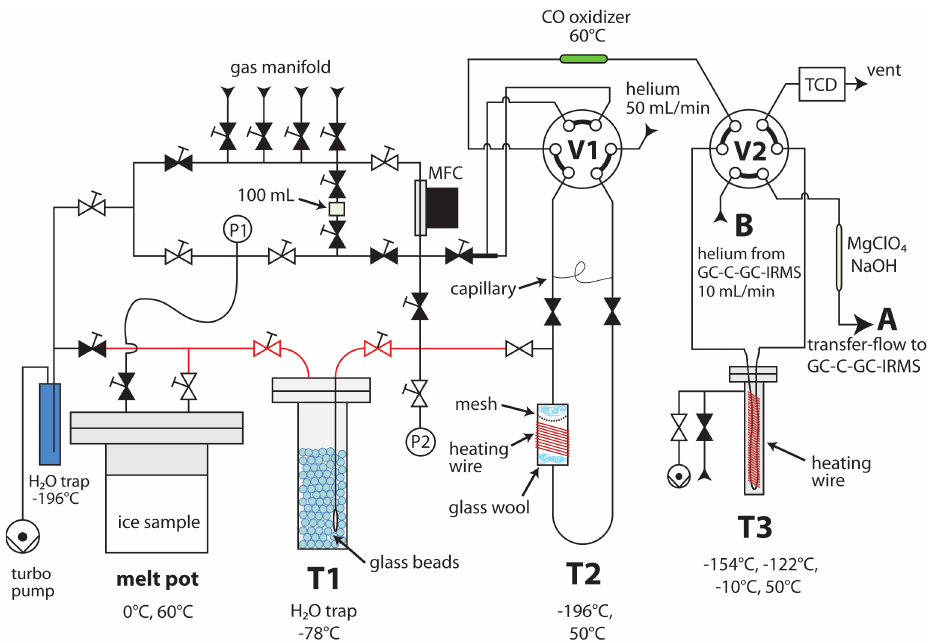
Fig. 1. Extraction unit design and flow scheme. Valve symbols with a handle symbolize manually operated valves, while symbols without a handle indicate automatically actuated valves. Filled valve symbols indicate closed valves; open symbols represent open valves. The figure shows the valve positioning of the extraction line during the melt extraction of an ice core sample. The red lines mark the section of the extraction unit which is thermally insulated and heated to 55 ◦ C. The letters A and B identify the ports of V2 that are connected to the respective port A at V5 and port B at V4 of the GC-C-GC-IRMS setup (Fig. 2). Port A transfers the sample to the GC-C-GC-IRMS unit, while port B receives the carrier-gas flow for